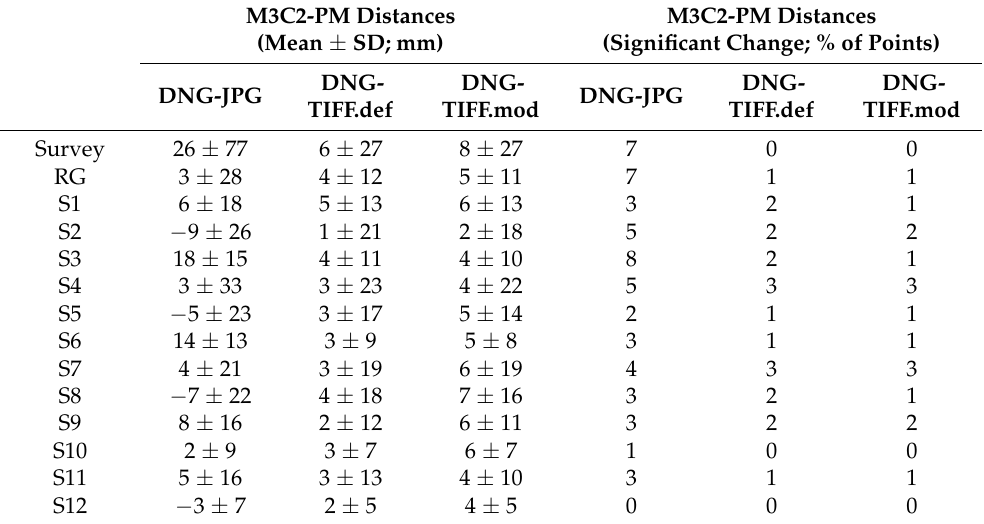
Table 5. Summary of 3D comparisons between the photogrammetric surveys of the different image sets in the areas studied. Mean and standard deviation of the differences are shown, as well as the percentage of points where the differences are significant (95% confidence